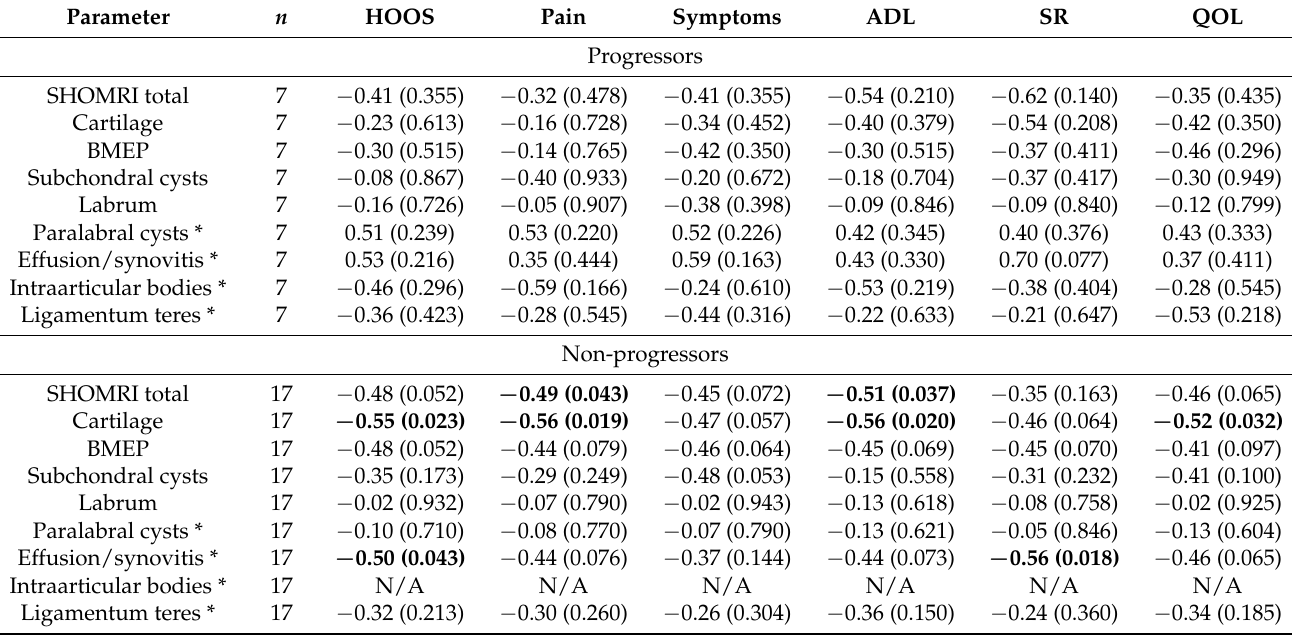
Table 7. Correlation analysis among symptomatic hip SHOMRI and HOOS at